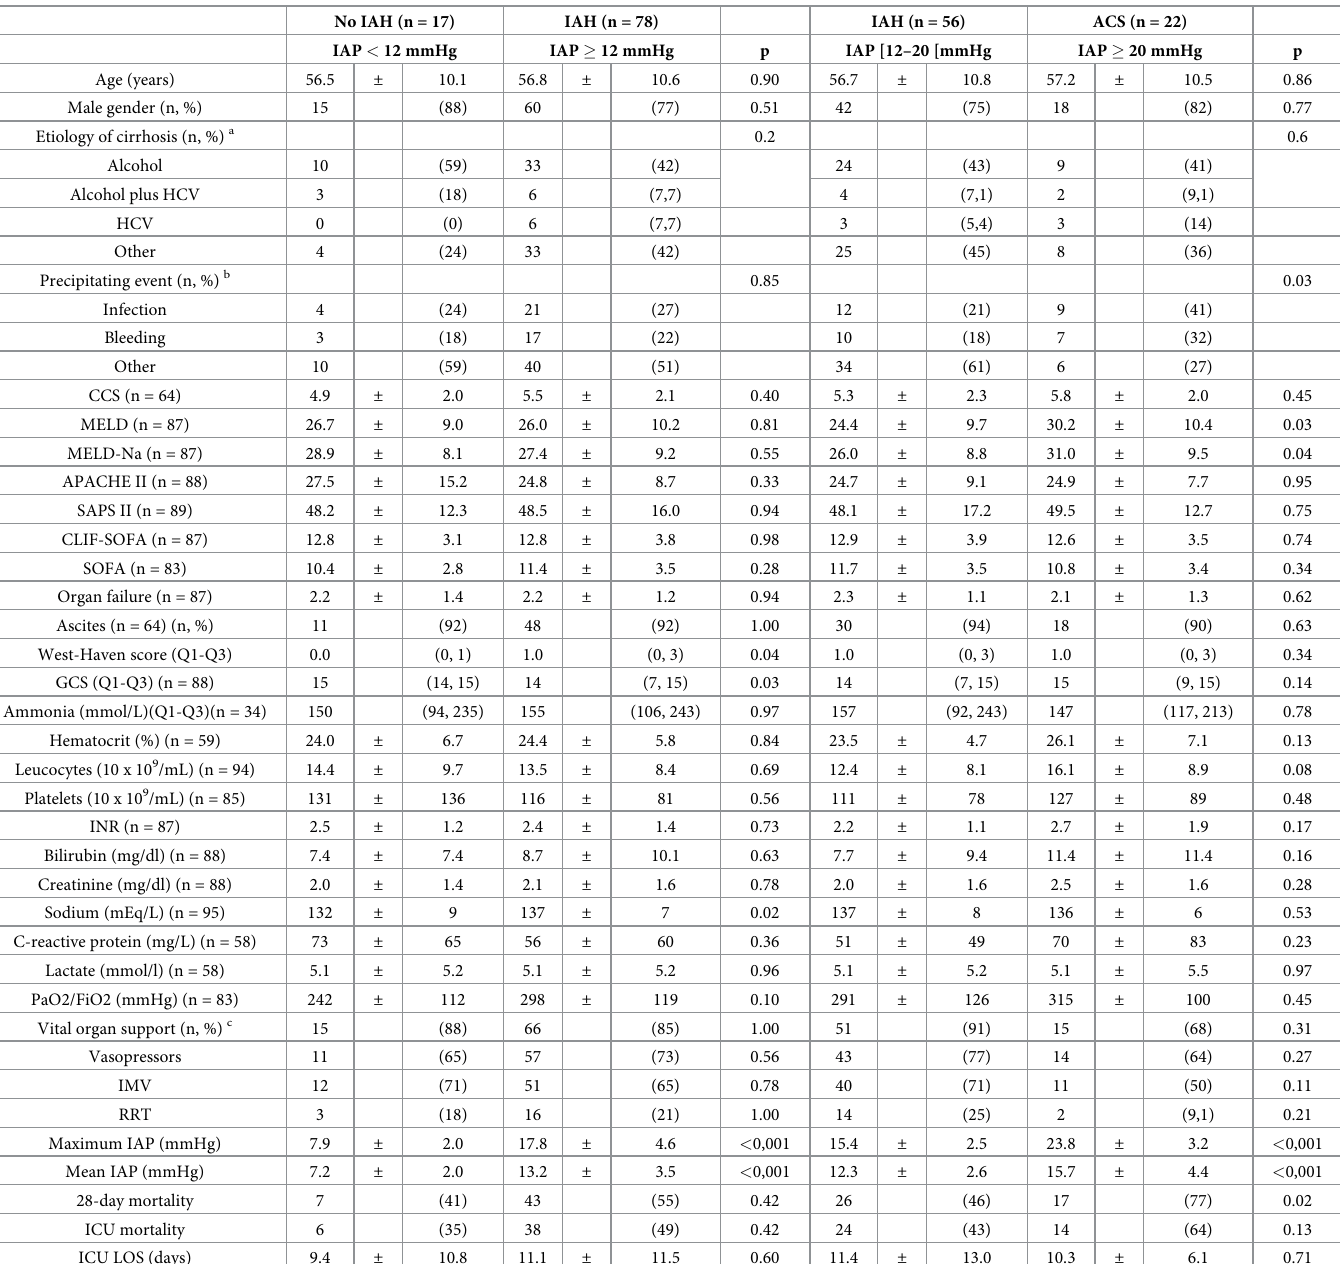
Table 2. Intra-abdominal hypertension in the critically ill cirrhotic